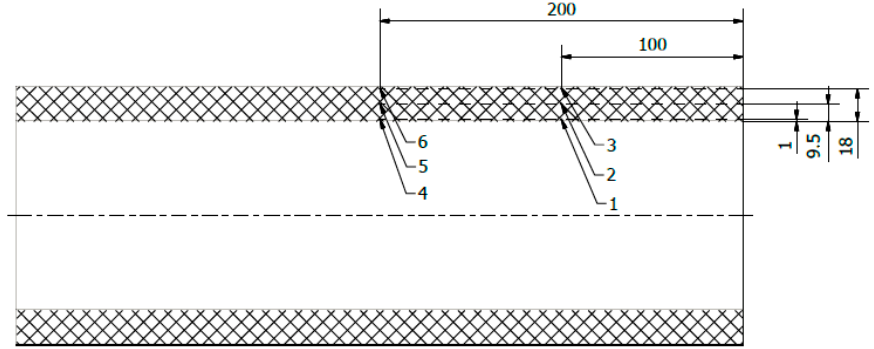
Figure 1. Diagram of the arrangement of temperature sensors (all dimensions in mm).